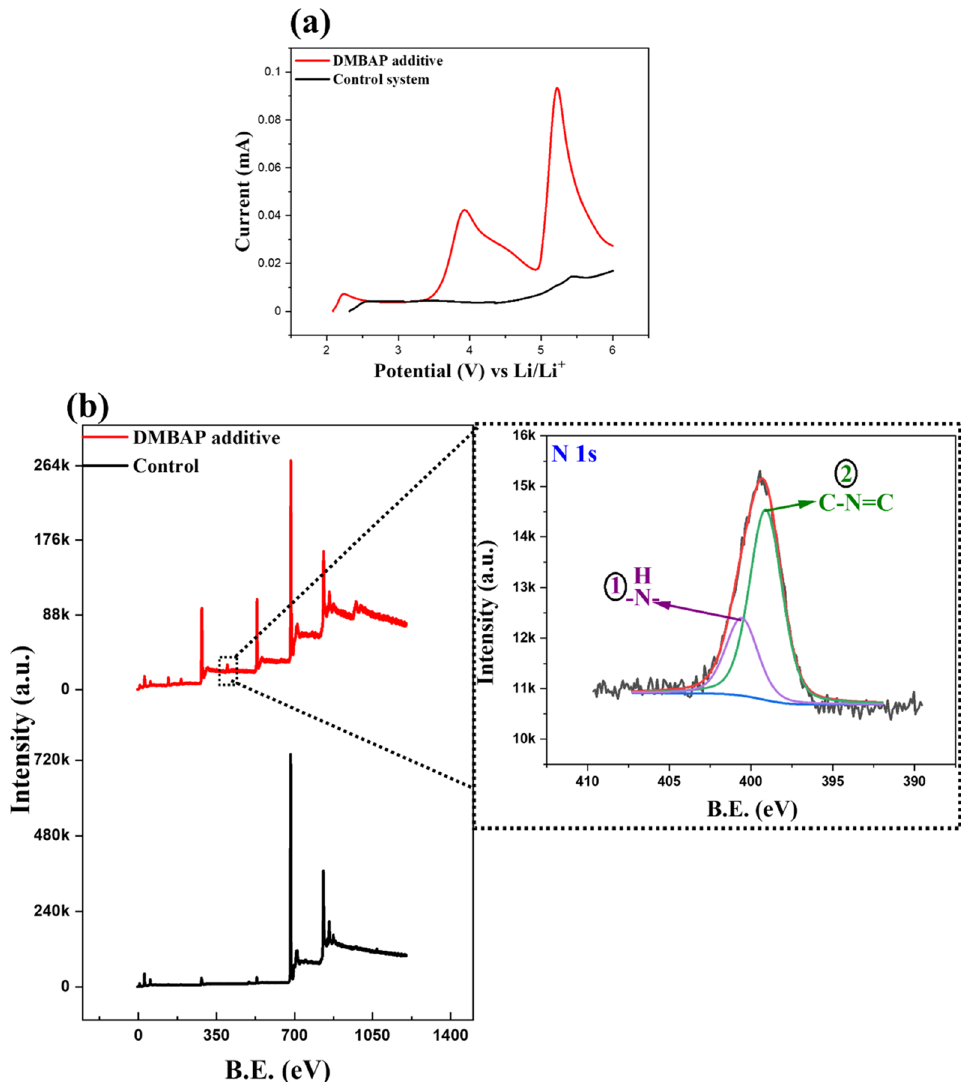
Figure 2. LSV studies and XPS characterization after LSV studies. ( a ) Oxidative linear sweep voltammogram from 0.0 to 6.0 V versus Li/Li + at a scan rate of 1.0 mVs −1 and ( b ) XPS spectra recorded after LSV measurements to determine the fate of DMBAP additive after oxidative decomposition in comparison to the control